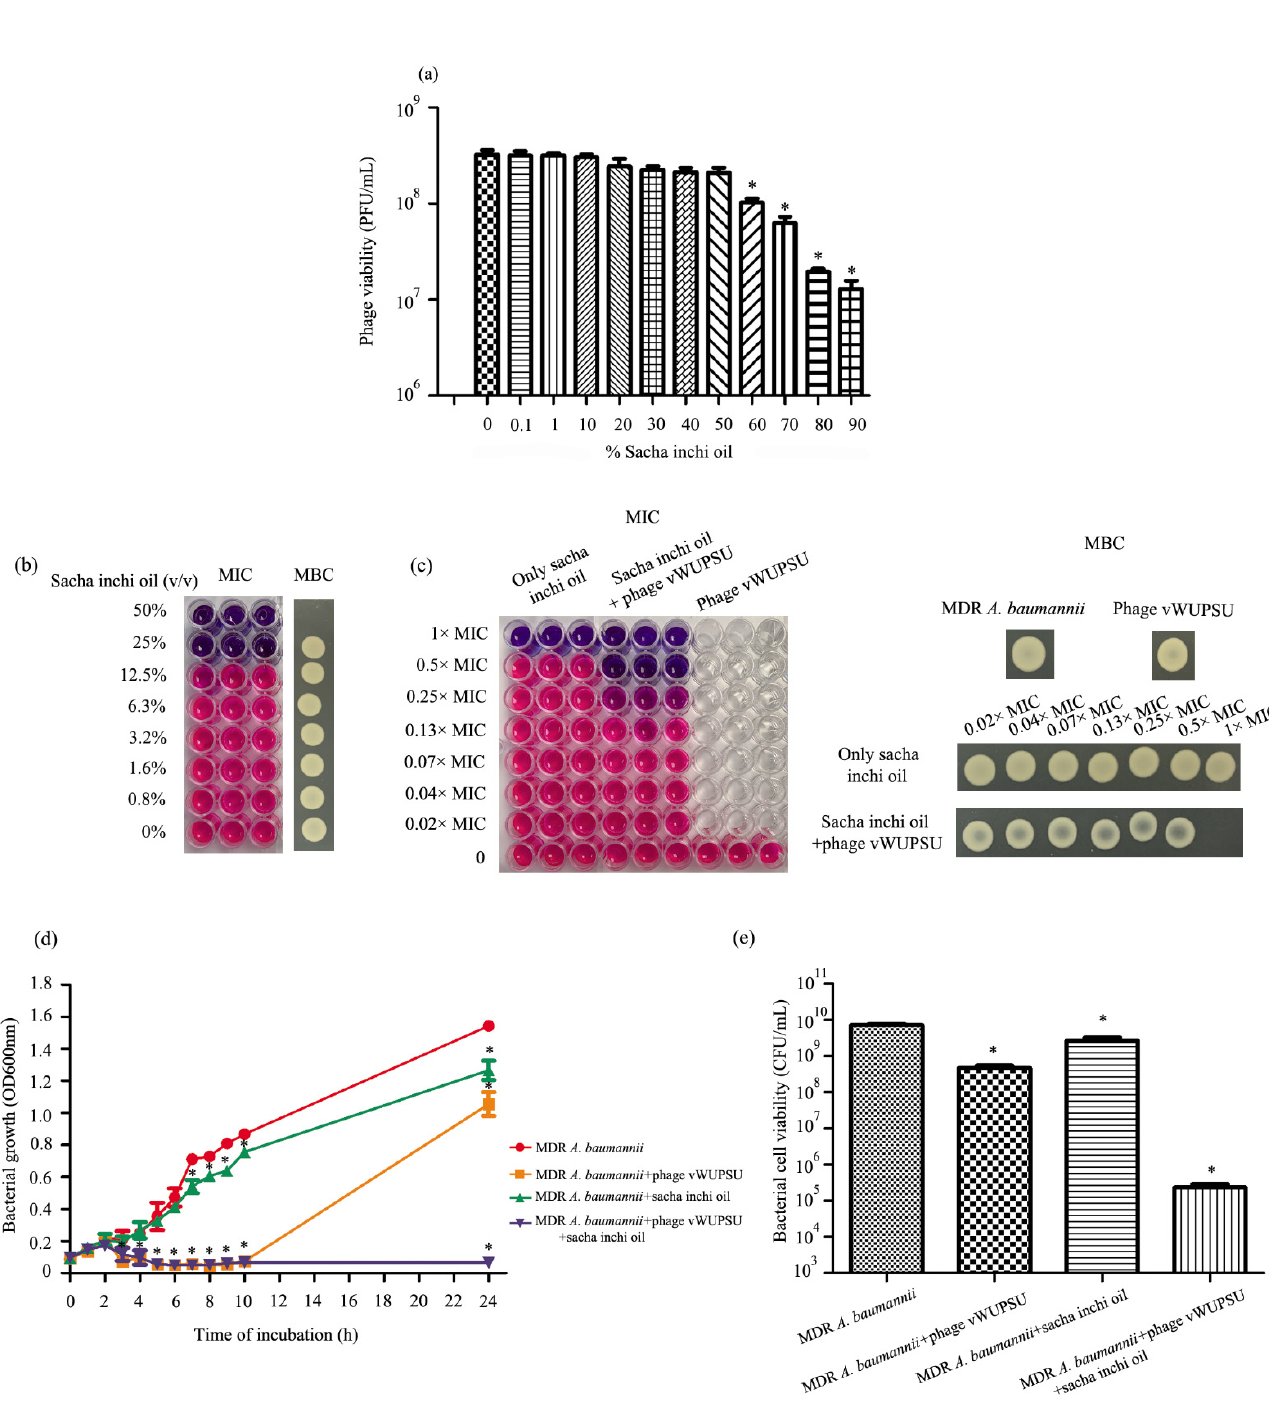
Figure 8. Possibility of the combination of phage vWUPSU and sacha inchi oil. ( a ) Phage viability after incubation with sacha inchi oil at 0.1% ( v / v ) to 90% ( v / v ). ( b ) Minimum inhibitory concentration (MIC) and minimal bactericidal concentration (MBC) values of sacha inchi oil. ( c ) MIC and MBC of the combination of phage vWUPSU at an MOI of 1 and sacha inchi oil. The lowest concentration before the color change was selected to determine the MIC. The concentration at which bacteria did not grow was the MBC value. ( d ) Lytic effect of a combination of sacha inchi oil at 0.5× MIC and phage vWUPSU at an MOI of 1 in vitro. ( e ) Impact of a combination of sacha inchi oil at 0.5× MIC and phage vWUPSU at an MOI of 1 on viable cell numbers. Experiments were undertaken independently in duplicate with a duplicate assay. The data show mean ± SD (*, p value < 0.05).